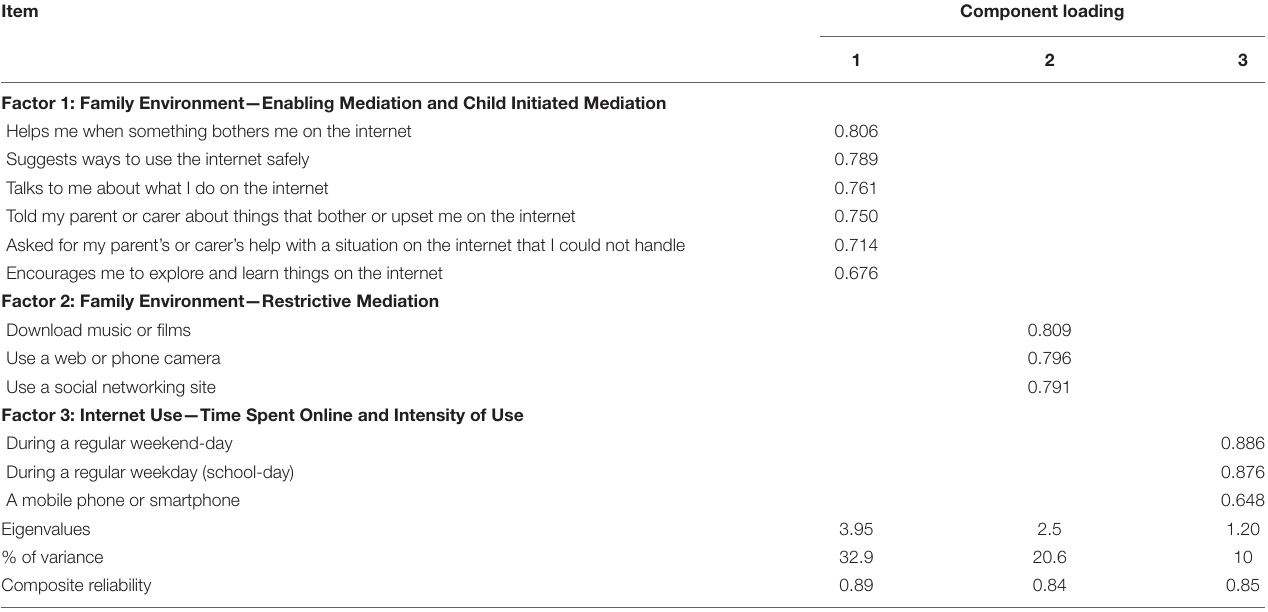
TABLE 2 | Results from the principal Component Analysis of the EUKO questionnaire.